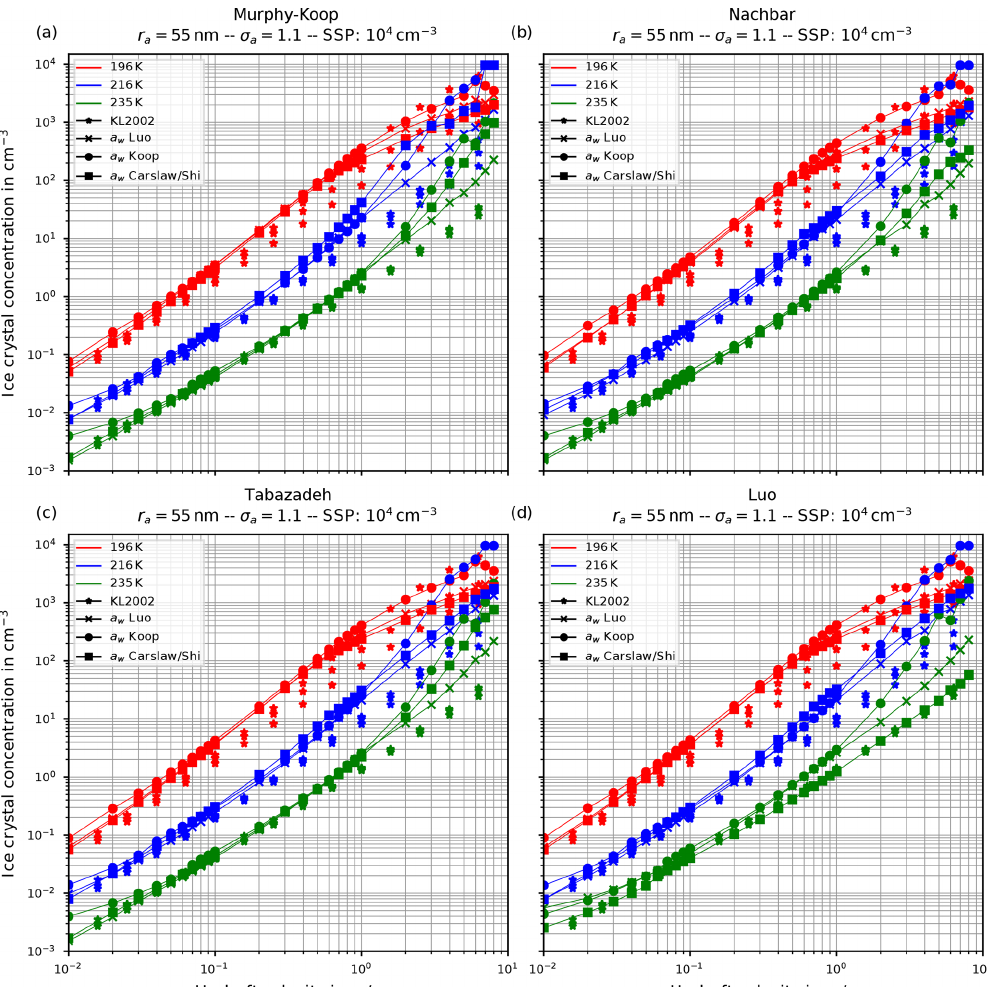
Figure 6. Number of homogeneously nucleated ice crystals as a function of the vertical updraft velocity with the choices r a = 55nm and σ a = 1 . 1 for the dry aerosol lognormal size distribution. Different panels correspond to different parameterizations of the saturation vapor pressure (also indicated in the title). Connected symbols indicate the number of nucleated ice crystals for the different formulations for water activity; star symbols show the data by Kärcher and Lohmann (2002) as in Fig. 1b. For further details, see the text. Note that SSP refers to the sulfuric acid aerosol particles (small solution